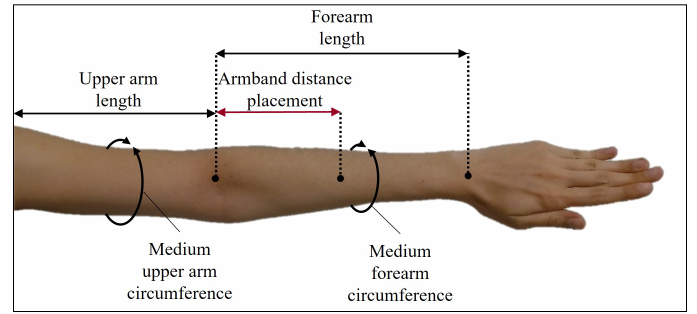
Figure 1. Anthropometric dimensions considered in the WyoFlex